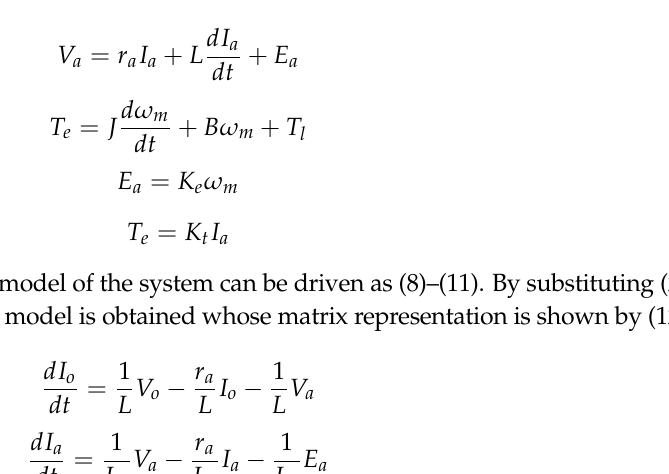
Figure 3. Equivalent circuit of Brushless DC (BLDC) motor.